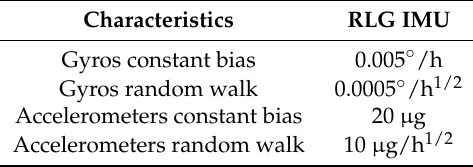
Table 5. Specifications of the RLG IMU.